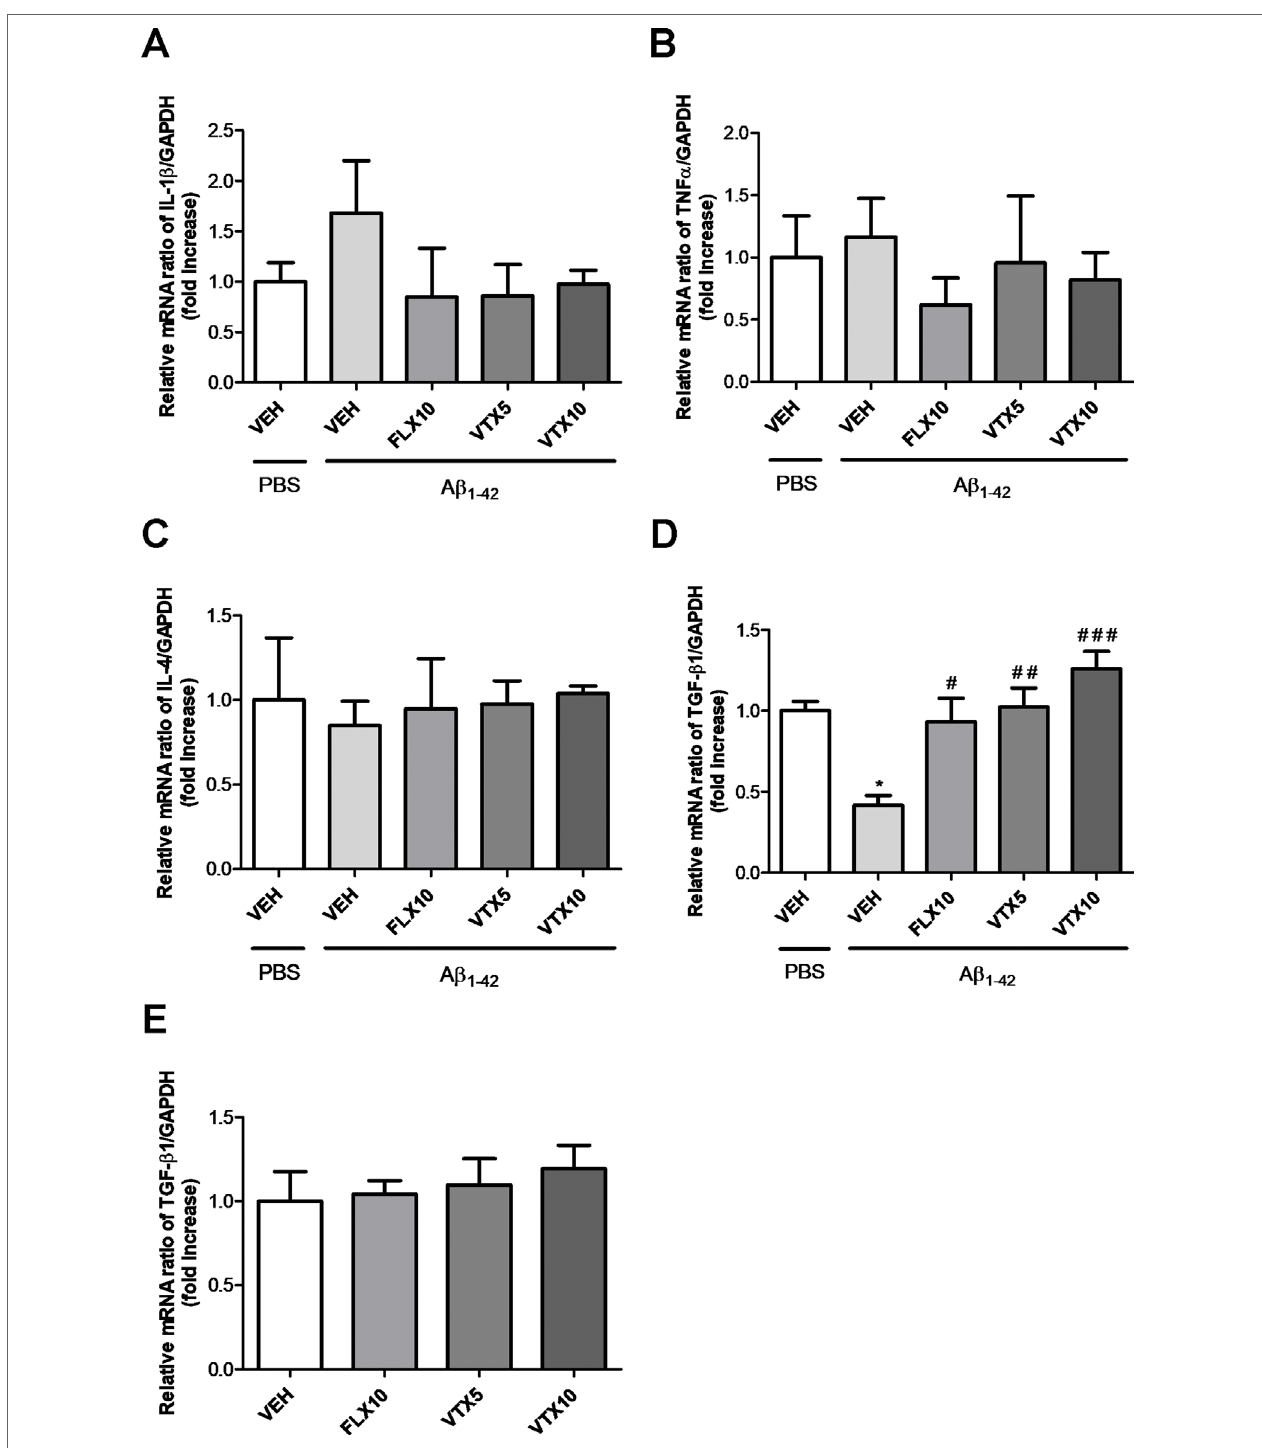
FIGURE 4 | Fluoxetine and vortioxetine increase the expression of TGF- β 1 mRNA. Effects induced by i.c.v. administration of A β 1-42 (A β 1-42 + VEH) in absence or presence of FLX10, VTX5, or VTX10 on IL-1 β (A) , TNF- α (B) , IL-4 (C) , and (D) TGF- β 1 mRNAs expression examined by qRT-PCR (Experiment 2). (E) Effects of drugs on TGF- β 1 mRNA expression in absence of A β 1-42 treatment (Experiment 3). The abundance of each mRNA of interest was expressed relative to the abundance of GAPDH-mRNA, as an internal control. As a negative control, a reaction in absence of cDNA (no template control, NTC) was performed. qRT-PCR amplifications were performed in quadruplicate. Data are shown as mean ± SEM. * p < 0.05 vs. PBS + VEH, # p < 0.05 vs. A β 1-42 + VEH, ## p < 0.01 vs. A β 1-42 + VEH, ### p < 0.001 vs. A β 1-42 + VEH; F (4,14) = 0.86 for (A) , F (4,10) = 0.35 for (B) , F (4,10) = 0.06 for (C) , F (4,15) = 10.23 for (D) , and F (3,19) = 0.35 for (E)